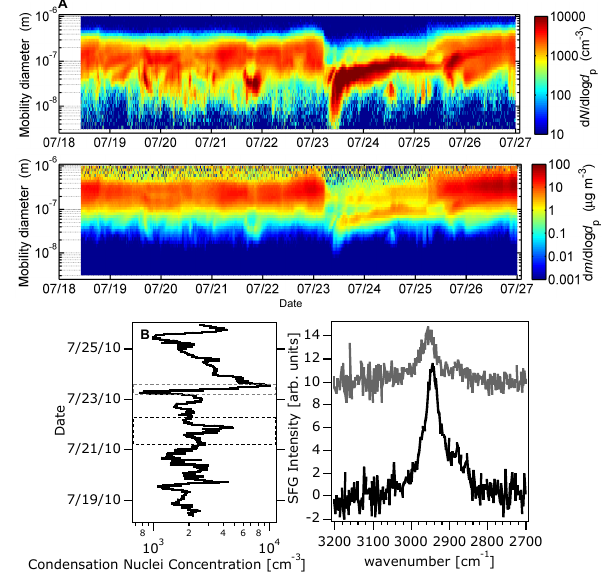
Fig. 4. (A) Aerodynamic mobility diameter and particle number density (top) and aerodynamic mobility diameter and mass particle size distribution (bottom) as a function of time of submicron-sized aerosol particles. (B) (Left) Total concentration of condensation nuclei in a supersaturated condensation chamber for the first week of the HUMPPA-COPEC-2010 campaign. The dashed boxes in- dicate the start and stop times for Teflon sampling filters FIN134 – 23 July 2010 (top) and FIN126 – 21 July 2010 (bottom), which sampled ambient air before (bottom) and during (top) a nucleation event. (Right) SSP-Polarized vibrational SFG spectra of a fused silica window pressed against filter FIN134 (top) and FIN126 (bot- tom). The SFG spectra are normalized to the same signal to noise ratio in the nonresonant frequency region to show the change in sig- nal yield from the filter with the lower particle